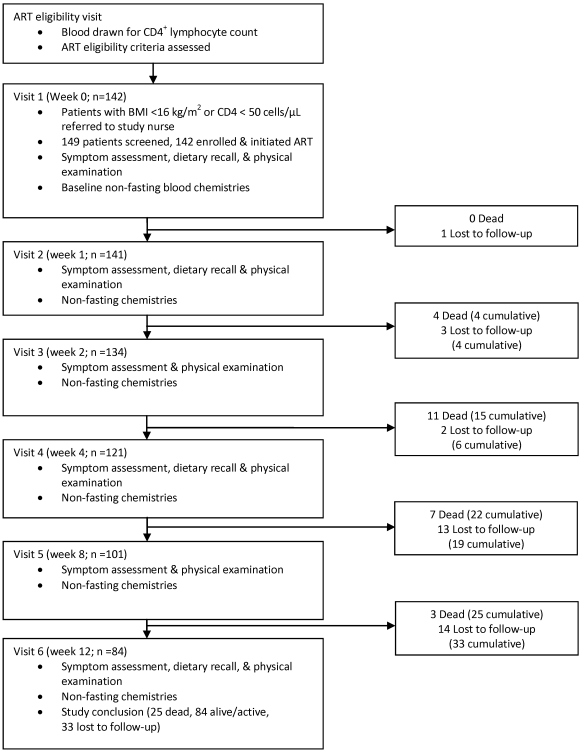
Study procedures and cohort status by study visit.